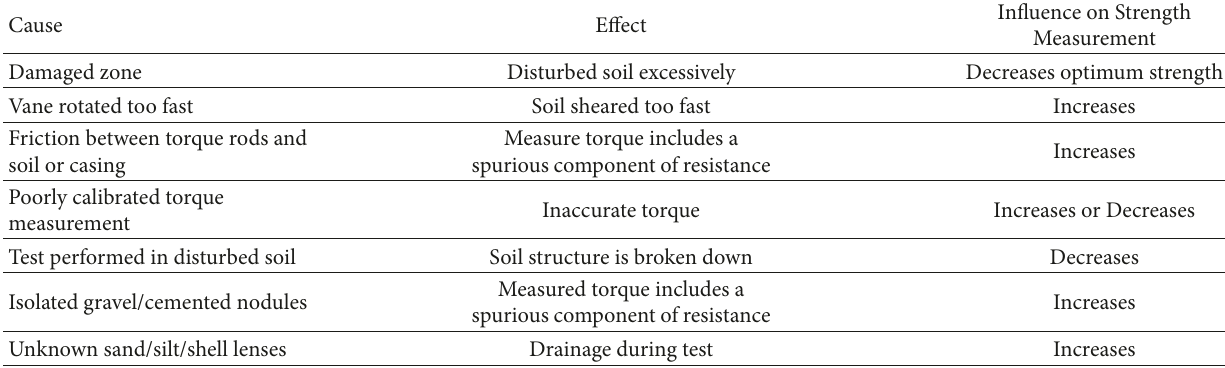
Table 1: Major source of error in the vane shear